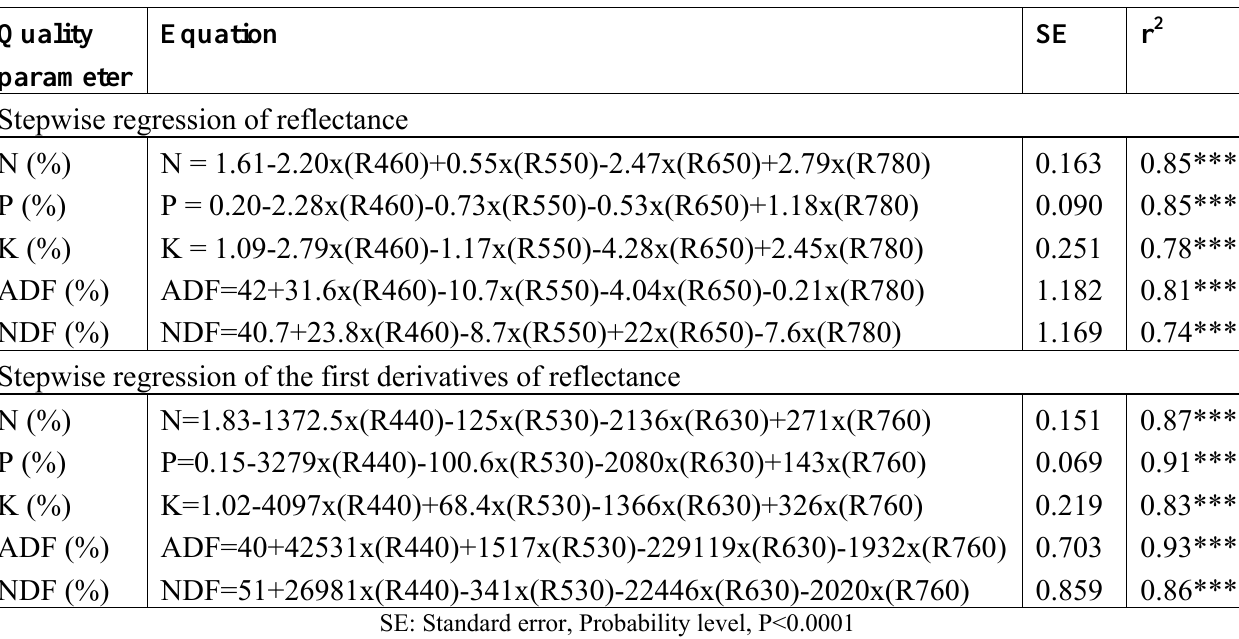
Table 5. Four wavebands (±5) selected from stepwise regression for determining relationships between reflectance and nutrition contents on the basis of calibration data set in sainfoin